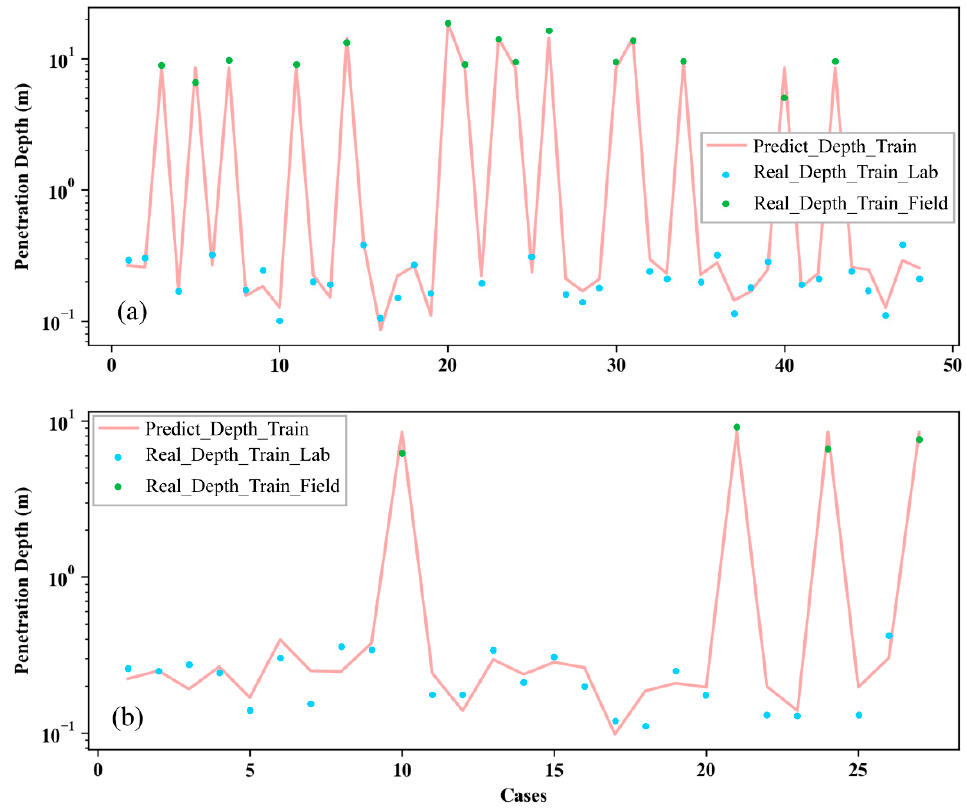
Figure 4. Comparison of machine learning model predictions with an actual penetration depth of gravity samplers. ( a ) Comparison of predicted depth values with actual depth values for train data; ( b ) comparison of predicted depth values with actual depth values for test data. The blue points represent the laboratory data obtained from physical model tests. The green points represent field data obtained from sea. Table 2. Prediction accuracy statistics of train set and test set.